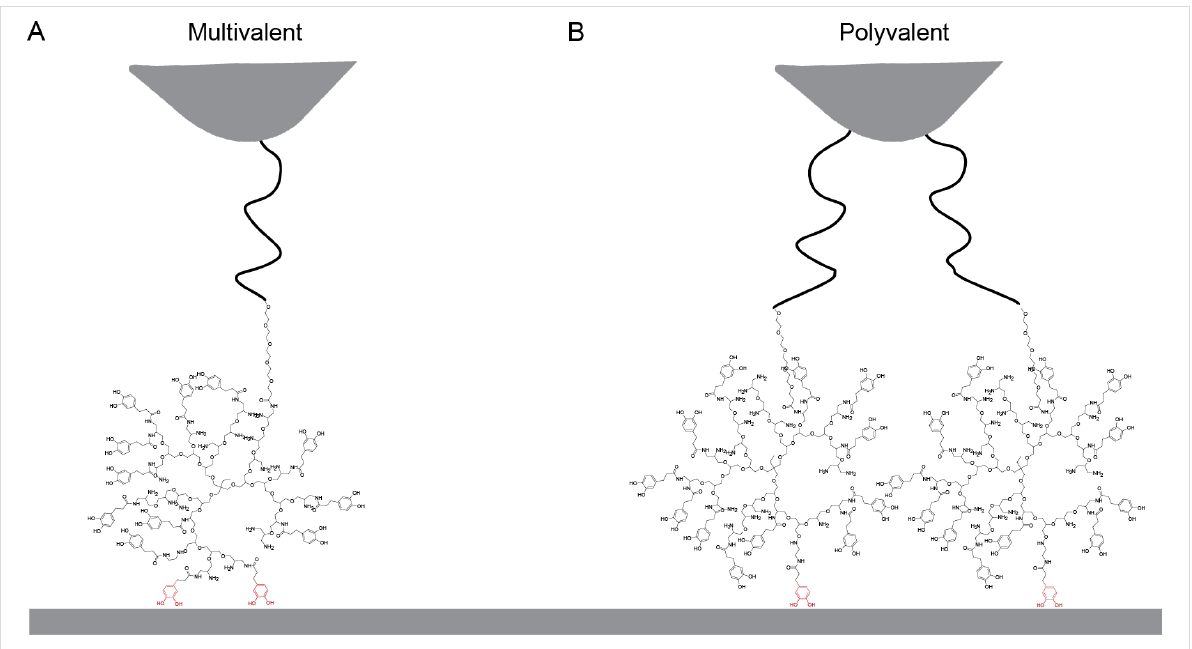
Figure 3: Schematics of the different possibilities for attachment via multiple catechols. A) Multivalent attachment: one hPG molecule is attached to the surface via two catecholic surface anchors. B) Polyvalent attachment: two hPG molecules are attached to the surface with one catechol each and they are attached to the tip via two different PEG linkers.